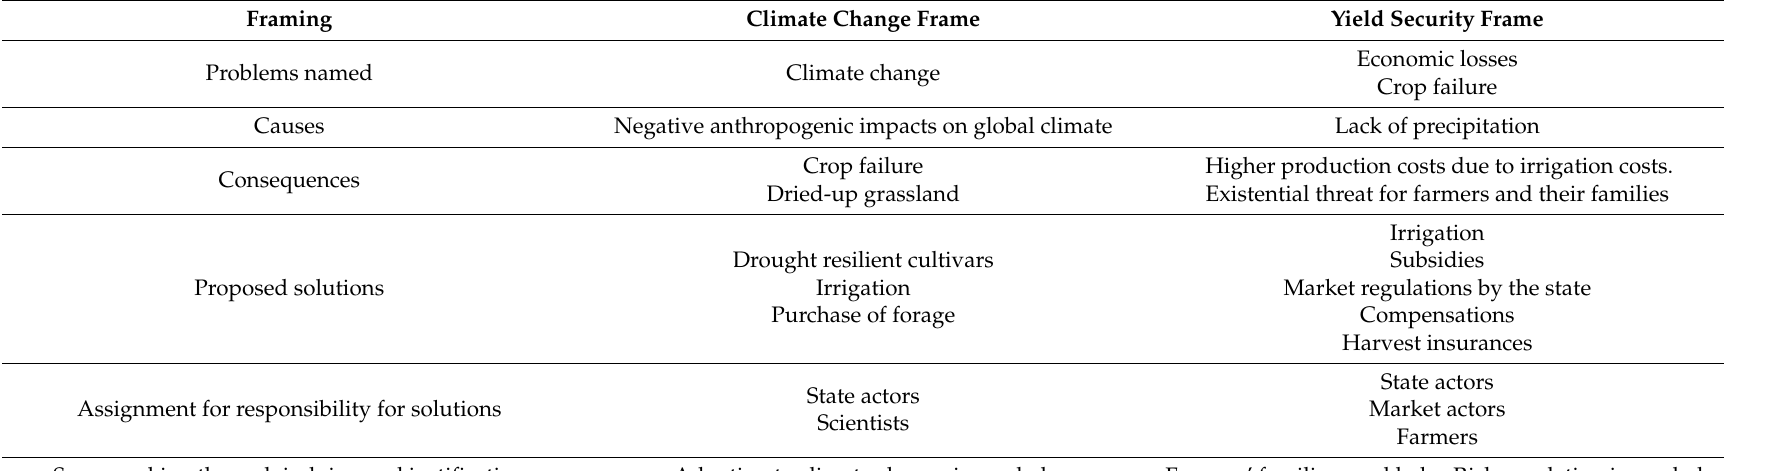
Table 4. Framing of drought by farmers in Baden-Württemberg 2011–16. Context: The forth investigation period 2011–16 was characterized by two droughts; one in 2011–12, the second in